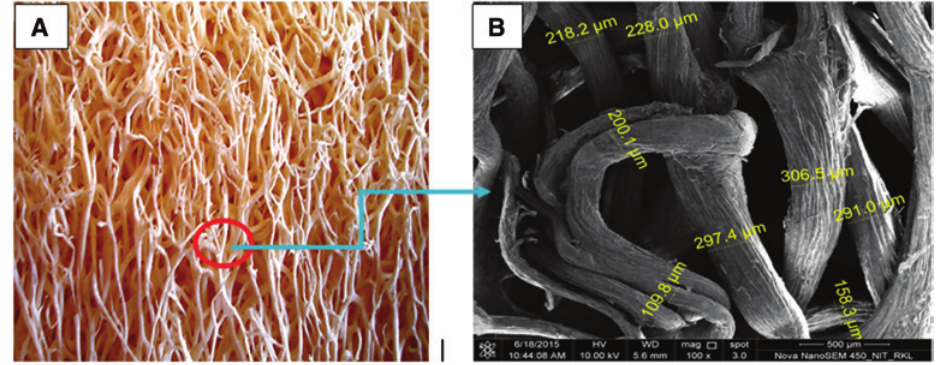
Figure 1: (A) Special natural network of the Luffa cylindrica fiber. (B) Same network with higher magnification ( ×